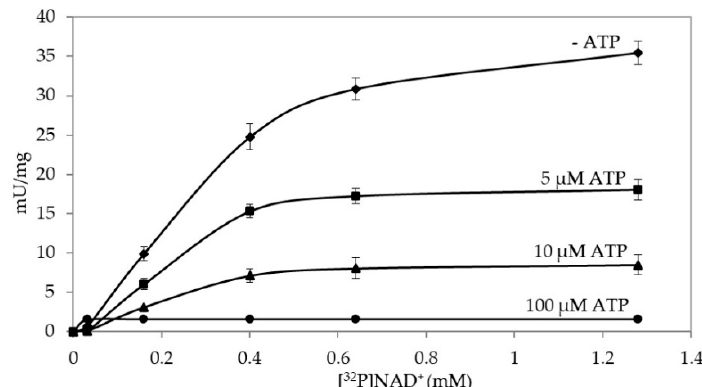
Figure 1. ATP e ff ect on PARPSso activity. Polymerase activity was assayed with [ 32 P]NAD + as Figure 1. ATP effect on PARPSso activity . Polymerase activity was assayed with [ 32 P]NAD + as described in § 2.5, in presence of di ff erent ATP concentrations ( µ M: 0, (cid:7) ; 5, (cid:4) ; 10, (cid:78) ; 100, • ). The basic described in § 2.5, in presence of different ATP concentrations ( μ M: 0, ♦ ; 5, ■ ; 10, ▲ ; 100, ● ). The kinetic curve ( (cid:7) ) is the one described in Figure basic kinetic curve ( ♦ ) is the one described in Figure S1.